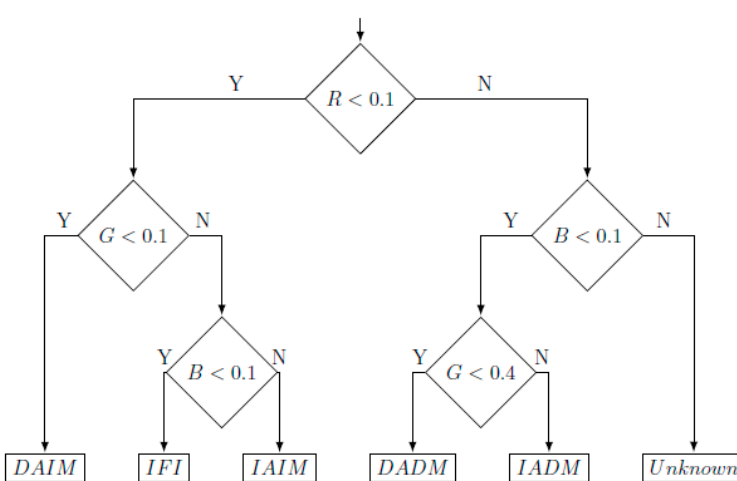
Figure 3. Decision tree used by the Sperm Functionality Module to classify spermatozoa into the different defined cell subtypes, according to plasma and acrosomal membrane integrity. For each image, the module shows the total number of cells, the number and the percentage of each subtype, and the percentages of sperm with acrosomal or plasma membrane integrity (Figure 4).